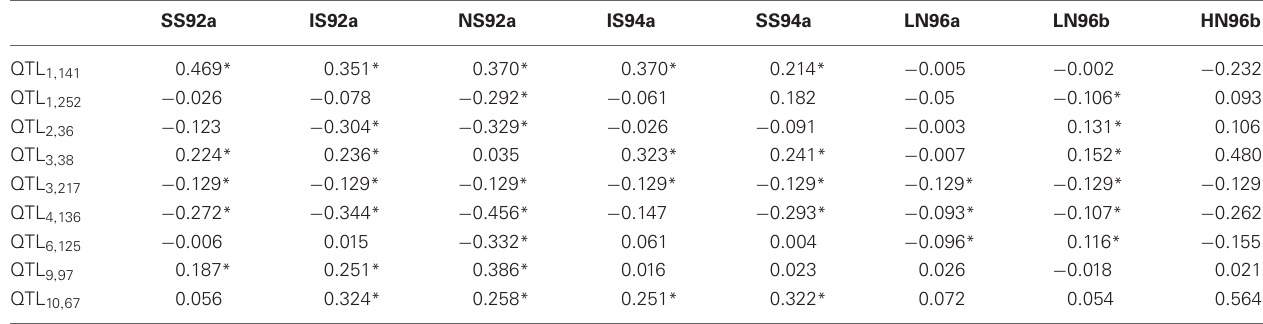
Table 8 | QTL effect estimates (ton · ha − 1 ) for individual environments.